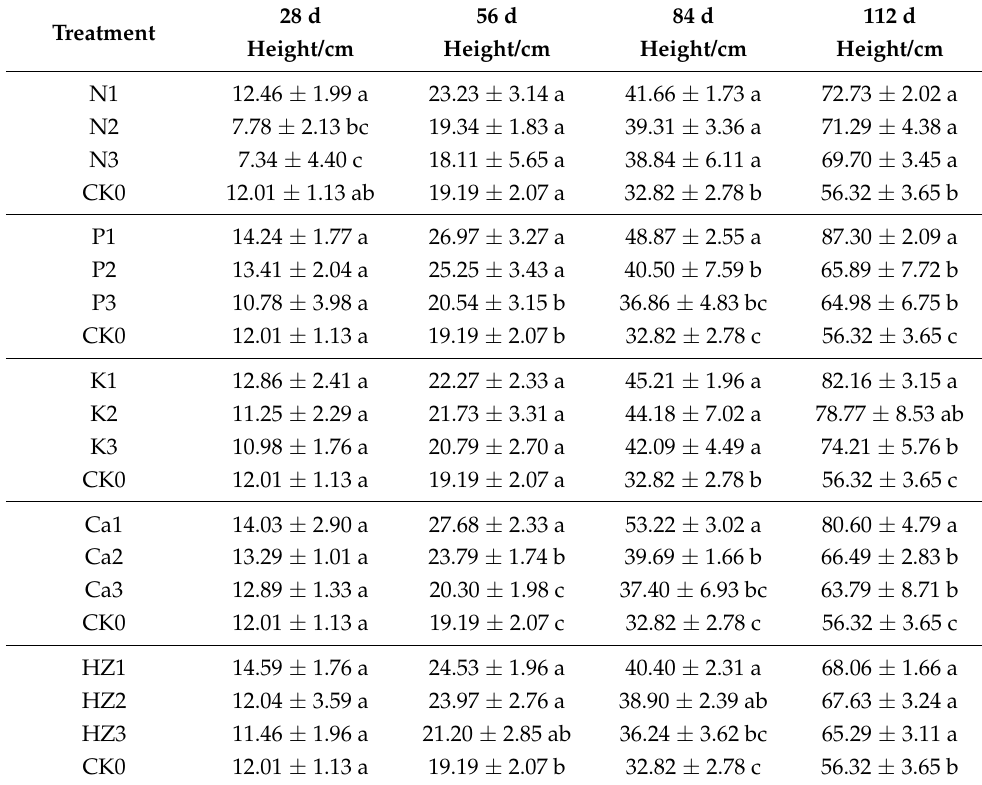
Table 2. Seedling height of Z. bungeanum after soil fertilization.